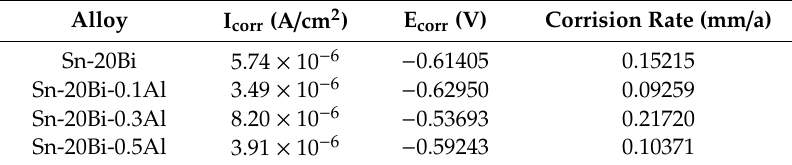
Table 2. The related parameters of Sn-20Bi-xAl alloys after polarized in 3.5 wt.% NaCl solution.